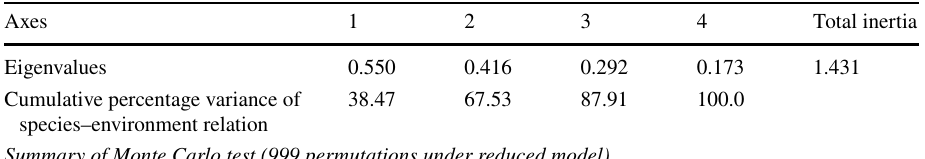
Table 5 Monte Carlo test of canonical correspondence analysis (CCA) using overall mean values to indicate phytoplankton−environment relationship at selected study sites